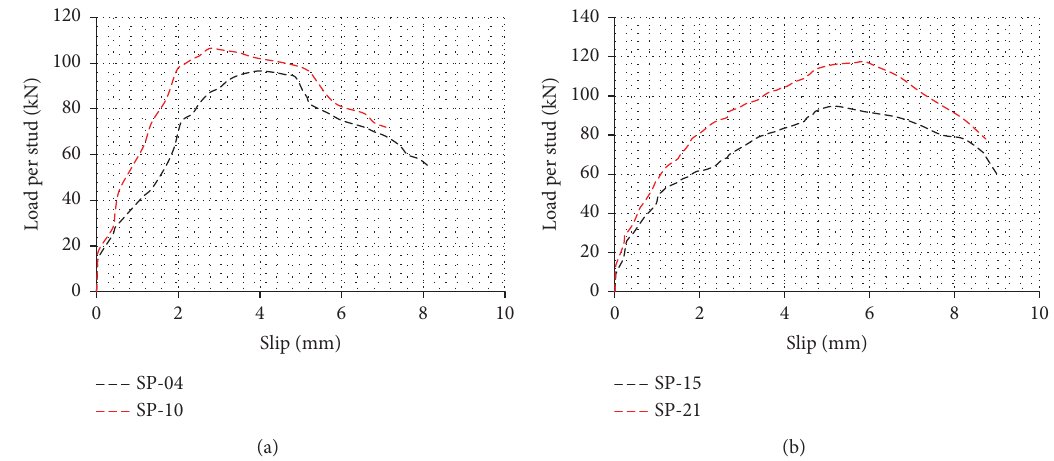
Figure 9: Effects of change in profiled steel sheeting rib depth on the capacity of the shear connector with (a) Open trough profiled steel sheeting and (b) Reentrant profiled steel